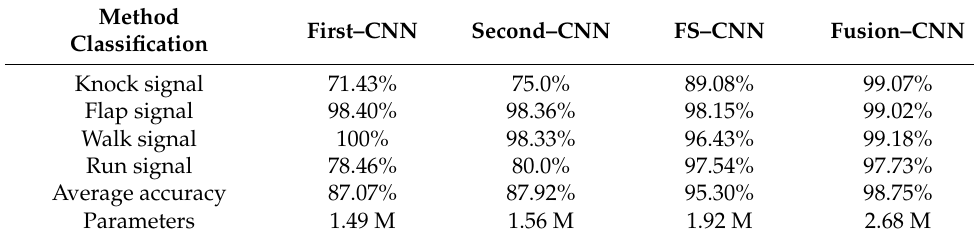
Table 3. Comparison of performance indicators of different